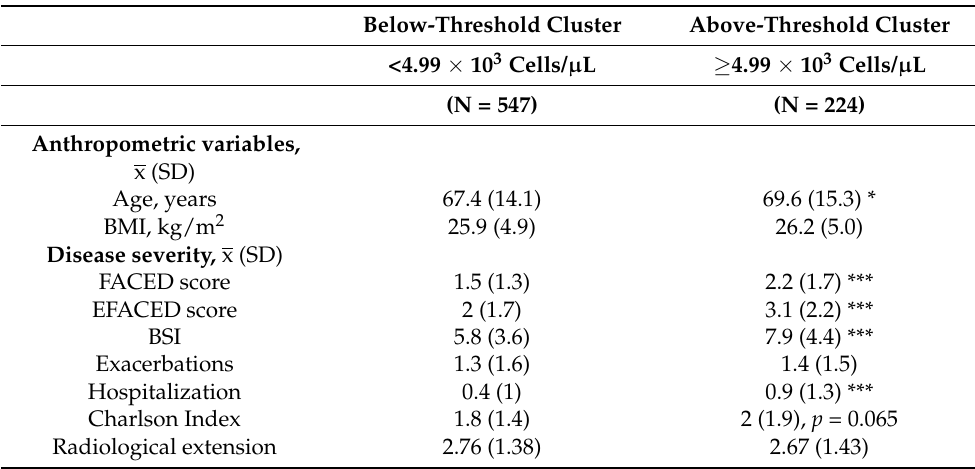
Table 3. General characteristics in the two clusters of bronchiectasis patients, excluding those with chronic colonization by